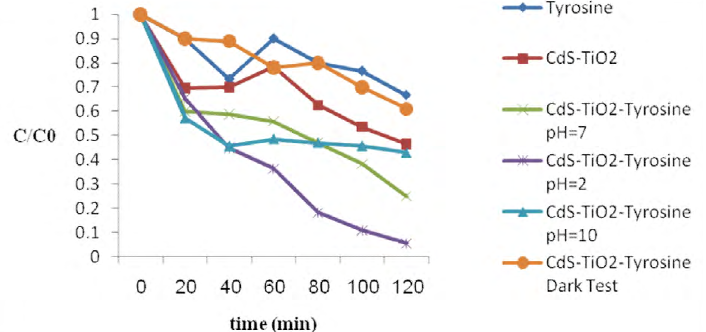
Fig. 13. The results of NB photoreduction with different catalysts and conditions (catalyst: 0.1 g, NB: 0.0136 M).